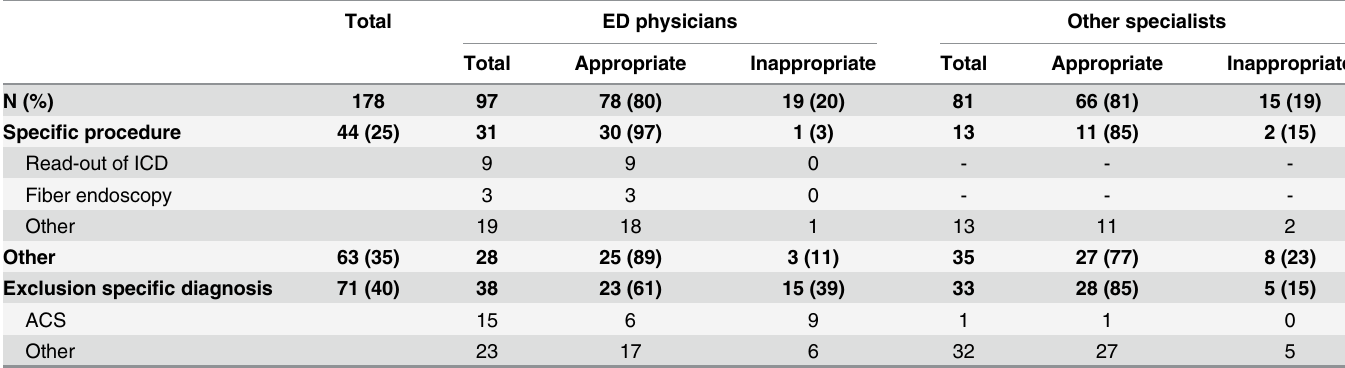
Table 3. Appropriateness of none mandatory